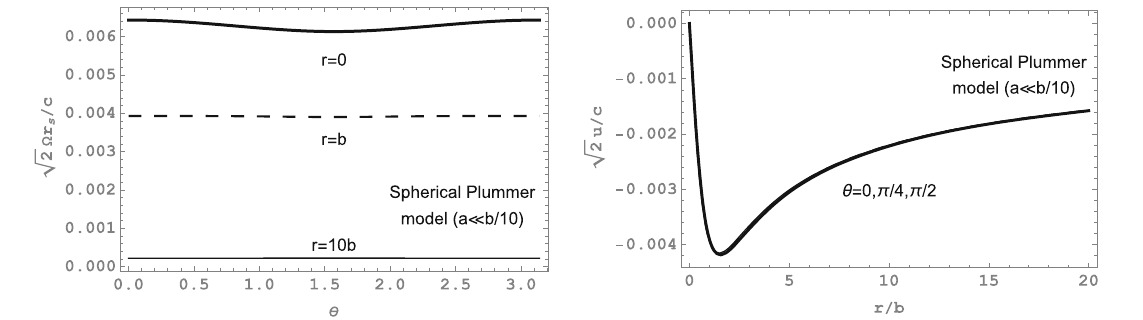
Fig. 2 Normalized angular velocity and rotation velocity profiles for an hypothetical dust distribution represented approximately by the spherical Plummer model. The right-hand panel shows that the rota-